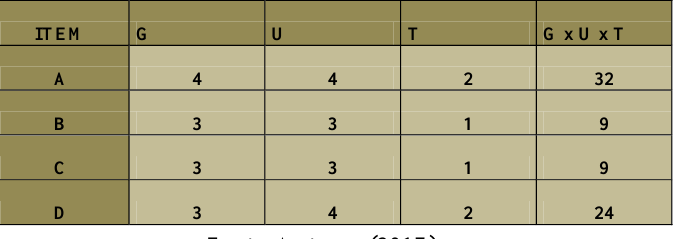
Tabela 10: Matriz GUT para as Principais Causas.